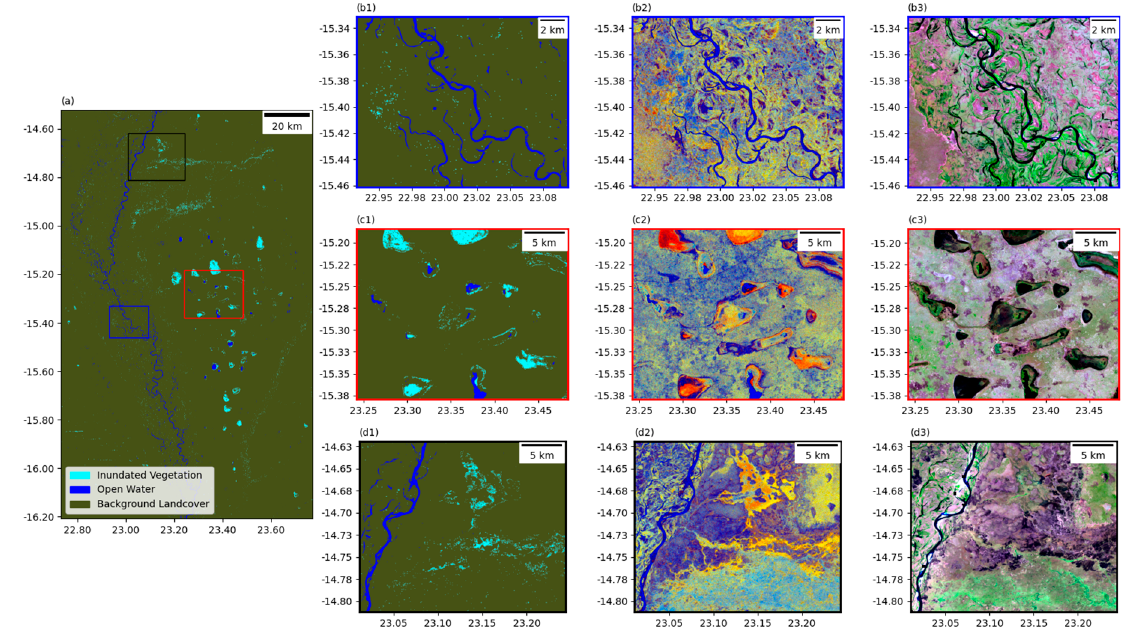
Figure 8. Example of RadWet dry season classified output over the Barotseland Floodplain dated 28 August 2018 ( a ). Subset figures represent the RadWet classified output, at representative lo- cations including Sentinel-1 imagery used for the classification, and reference Sentinel-2 optical image. Specifically, ( b1 – b3 ) is a section of the main Zambezi channel and surrounding river features; ( c1 – c3 ) represents dambo features atop the eastern escarpment; and ( d1 – d3 ) is the location of the in-flow of the Leuna floodplain into the main Barotseland Floodplain.